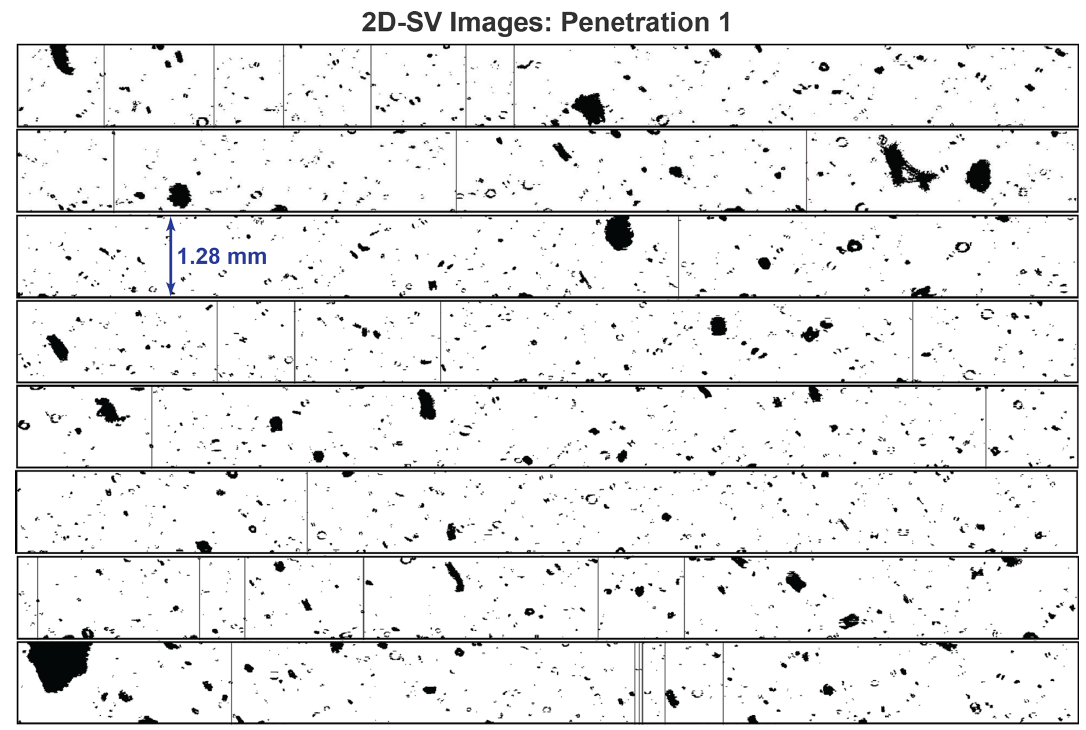
Figure 7. Sampling of 2D-SV particle images for penetration 1 (Fig. 1d, Table 2). Vertical distance of each horizontal strip represents